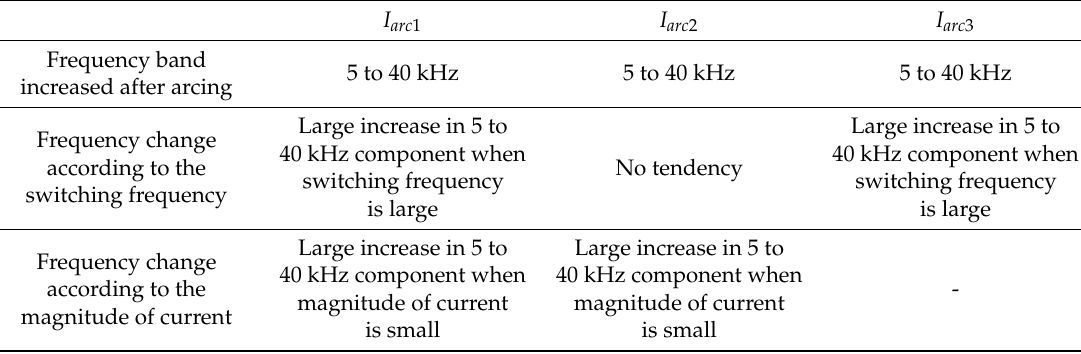
Table 4. Results of analysis of arc current frequencies for various frequency fluctuations.